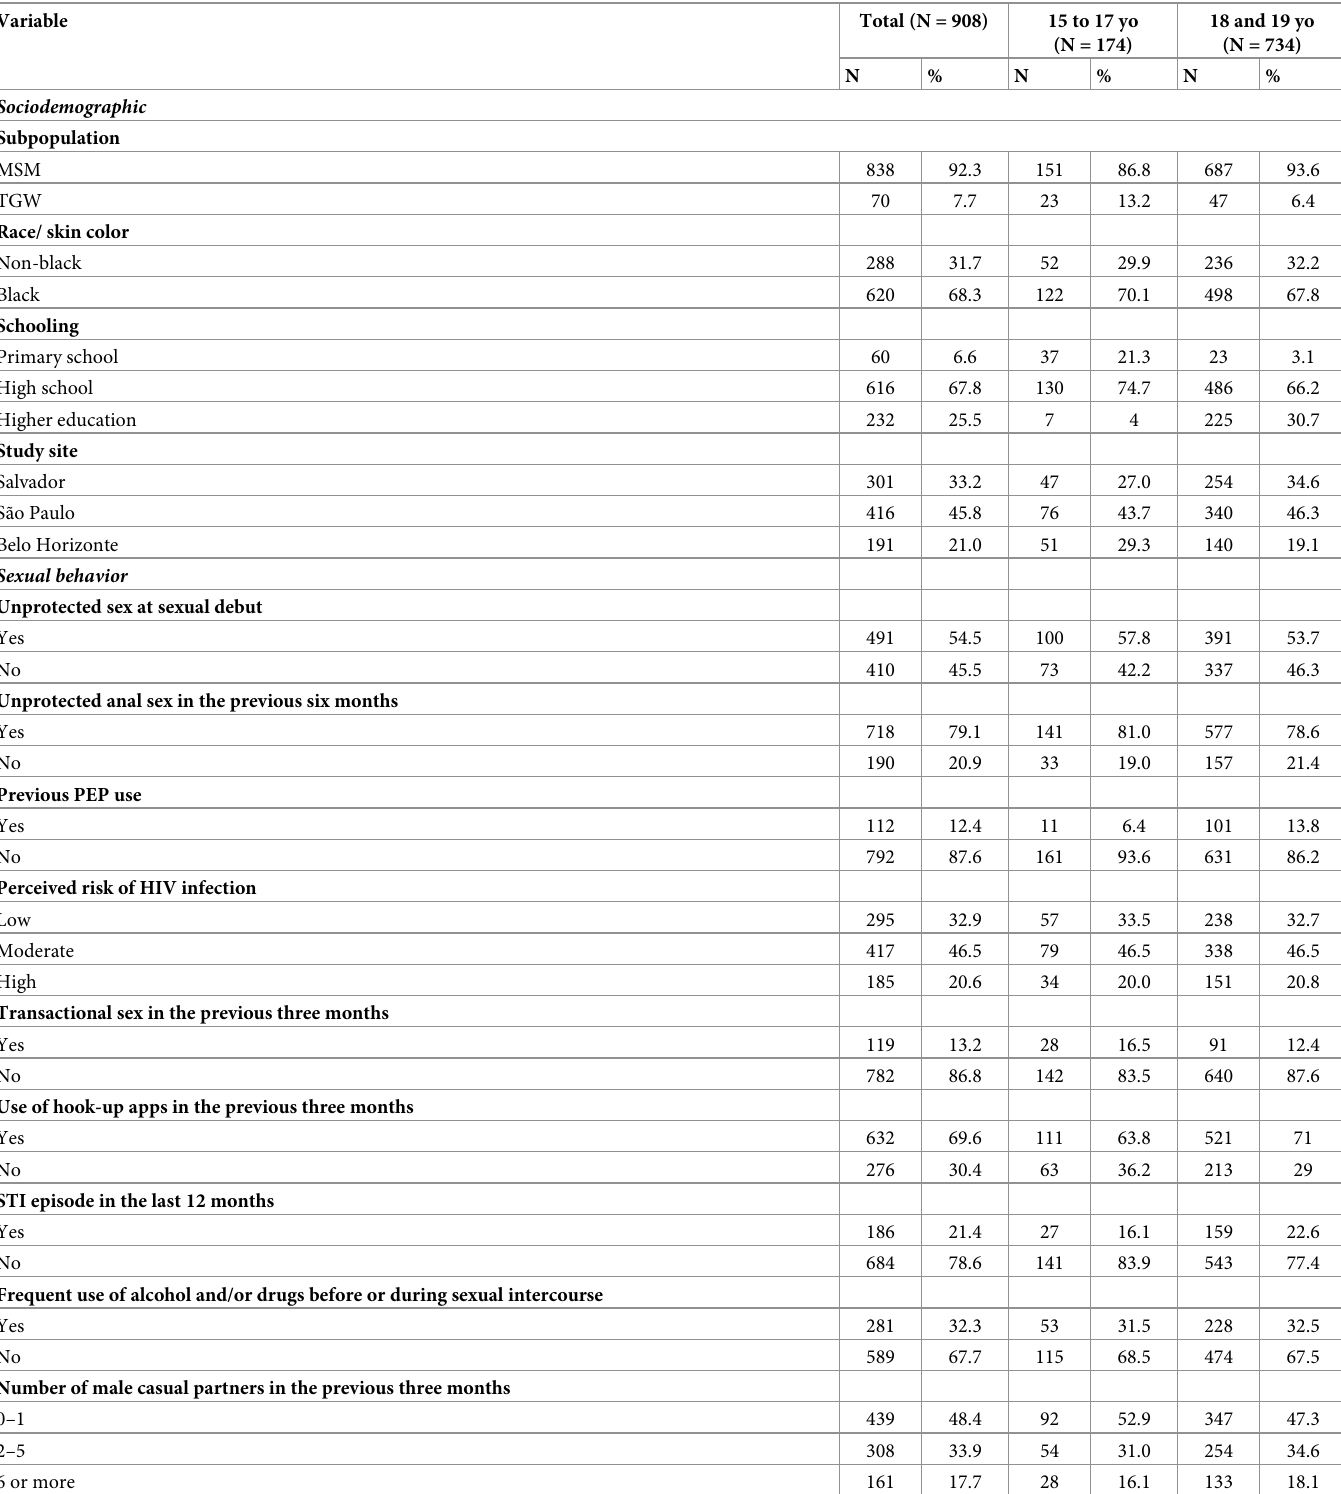
Table 1. Characteristics of the adolescent MSM and TGW enrolled in the PrEP1519 cohort by age groups. February 2019—February 2021. Variable Total (N =